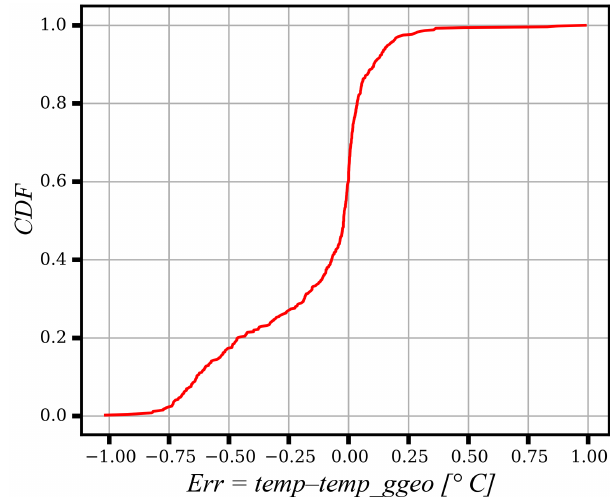
Figure 14. Cumulative distribution function (CDF) of the soil tem- perature difference at the h T -non-oscillation depth between simu- lations with and without geothermal